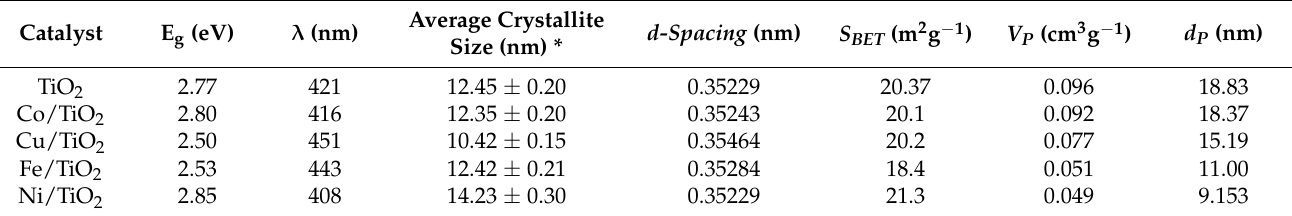
Table 1. Optical and textural properties for the TiO 2 and deposited-TiO 2 photocatalysts.